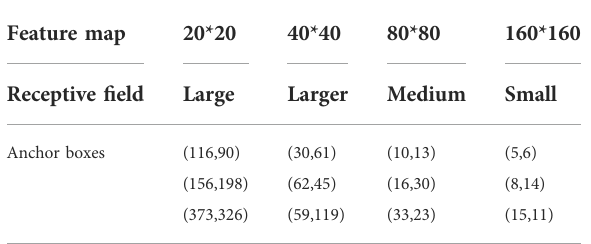
TABLE 1 Anchor Box allocation